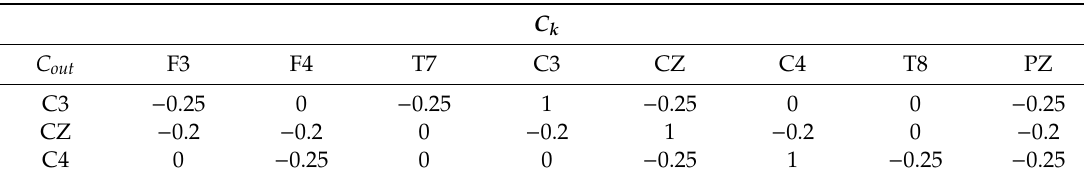
Table 1. Laplacian filter coefficients. C k = electrode k signal.